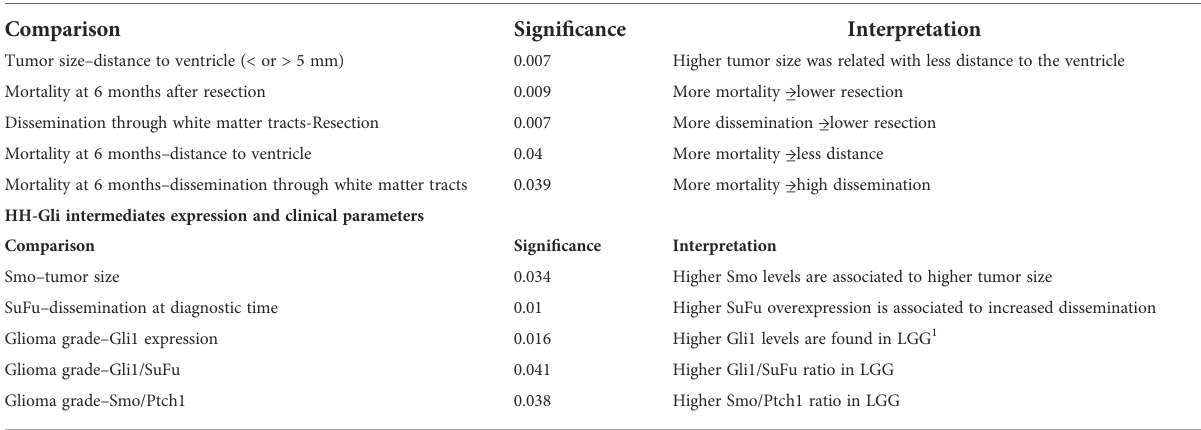
TABLE 1 Comparison of clinical parameters among themselves and its association with HH-Gli intermediates expression. Clinical